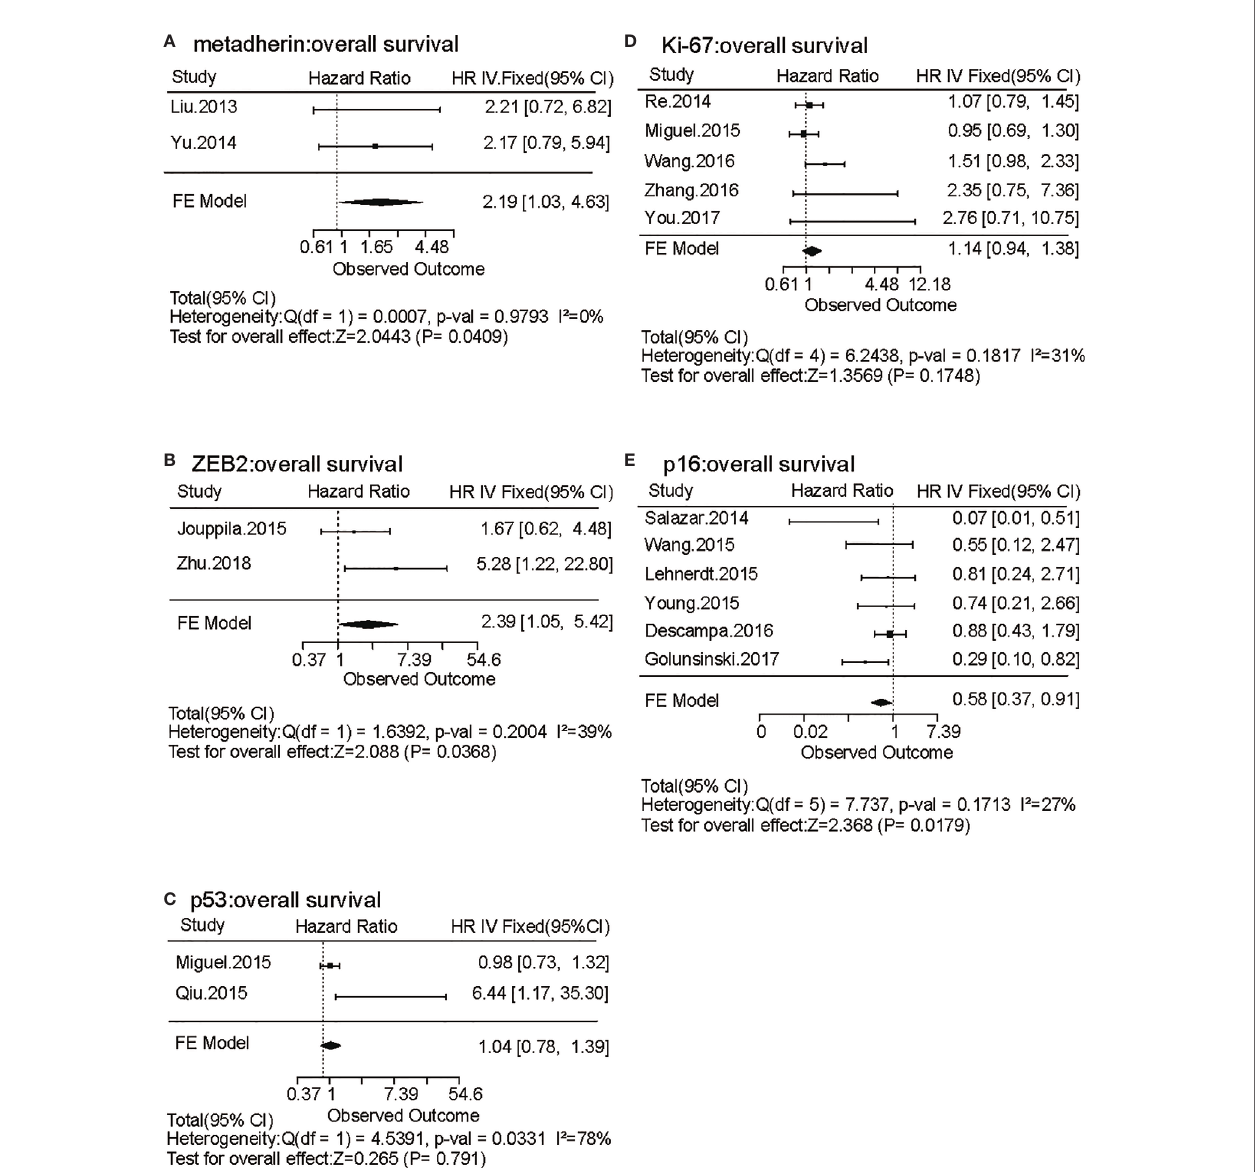
FIGURE 2 | Forest plots of the effects of fi ve biomarkers evaluated by two or more independent studies on laryngeal and pharyngeal HNSCC survival. (A – E) Forest plots of hazard ratio (HR) for overall survival (OS) of metadherin (A) , ZEB2 (B) , p53 (C) , Ki-67 (D) , and p16 (E) are shown based on a fi xed effect model. Bars present 95% con fi dence intervals (CI) of HR, and the center of the lozenge gives the combined HR. Combined fi xed effect HRs and tests for heterogeneity (I 2 ) are based on the generic inverse variance (I-V)